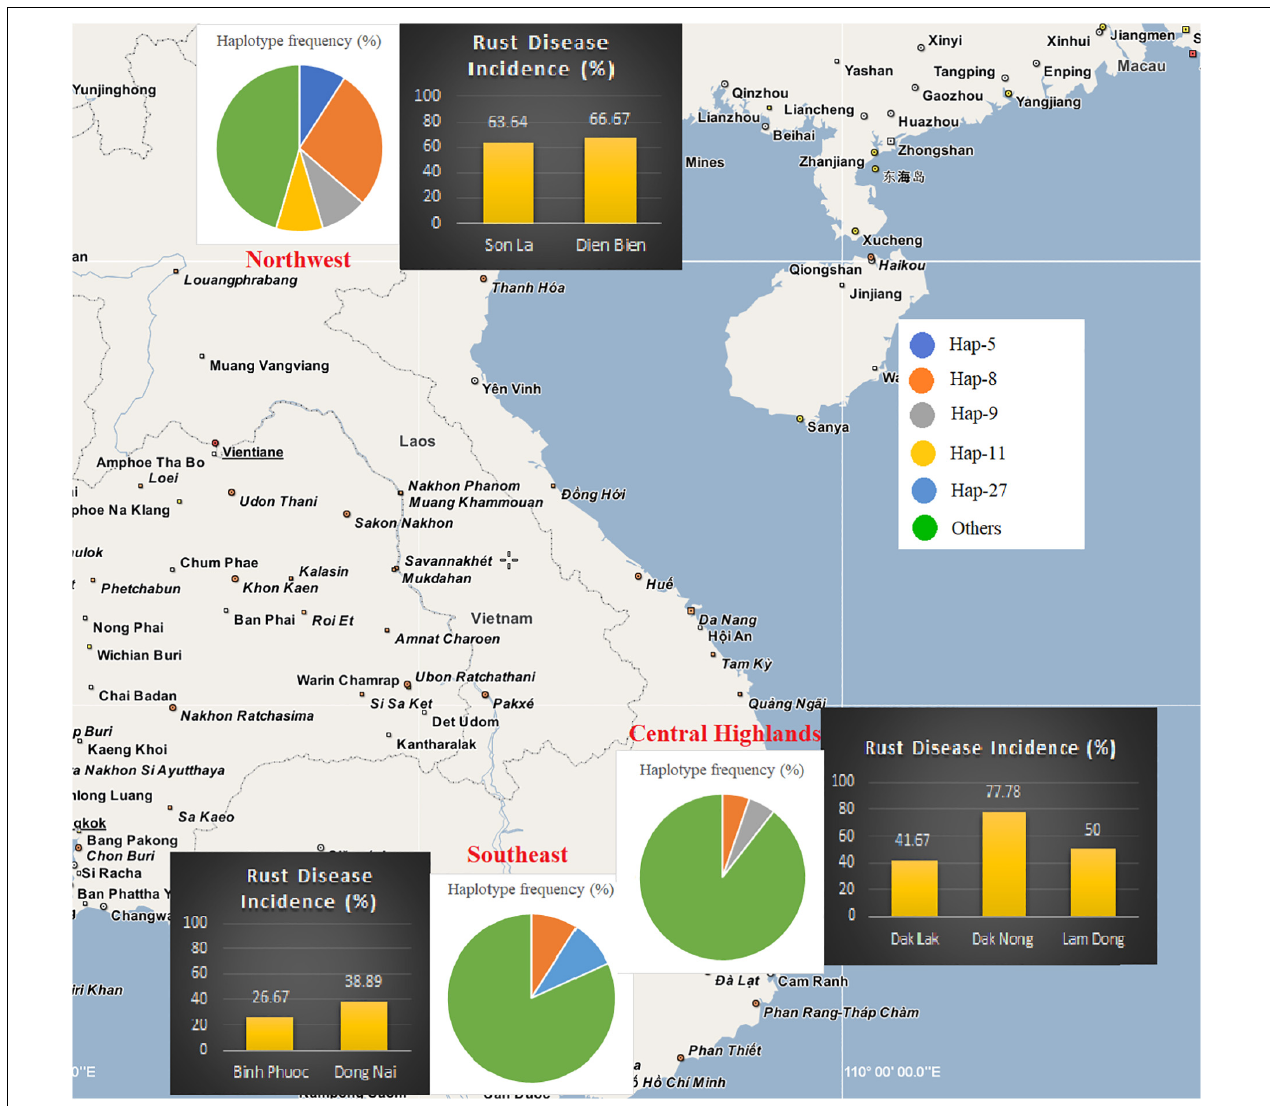
FIGURE 1 | Rust disease incidence and the frequency of ancestral Hemileia vastatrix haplotypes in different geographical sample areas of Vietnam. Disease incidence in the areas of each province is indicated using bar charts and Hemileia vastatrix haplotype frequency in the sampling areas is shown using pie